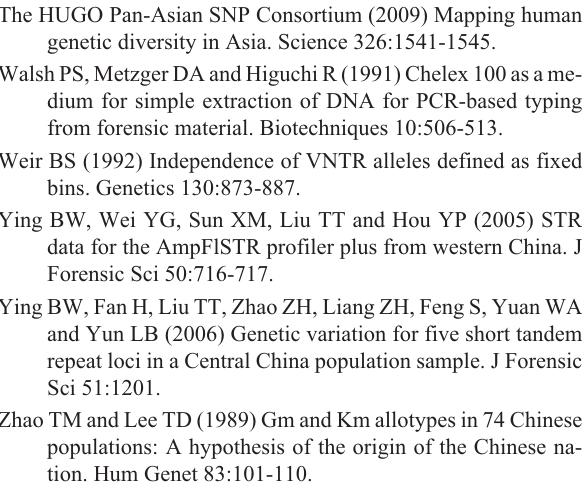
Table S4: Genetic polymorphism at the TH01 locus for the seven Chinese population groups. Table S5: Genetic polymorphism at the CSF1PO lo- cus for the seven Chinese population groups. Table S6: Genetic polymorphism at the D7S820 locus for the seven Chinesepopulation groups. Table S7: Genetic polymorphism at the VWA locus for the seven Chinese population groups. Table S8: Genetic polymorphism at the FGA locus for the seven Chinese population groups. Table S9: Genetic polymorphism at the D8S1179 lo- cus for the seven Chinese population groups. Table S10: Genetic polymorphism at the D21S11 lo- cus for the seven Chinese population groups. Table S11: Genetic polymorphism at the D18S51 lo- cus for the seven Chinese population groups. Table S12: Genetic polymorphism at the D5S818 lo- cus for the seven Chinese population groups. Table S13: Genetic polymorphism at the D13S317 lo- cus for the seven Chinese population